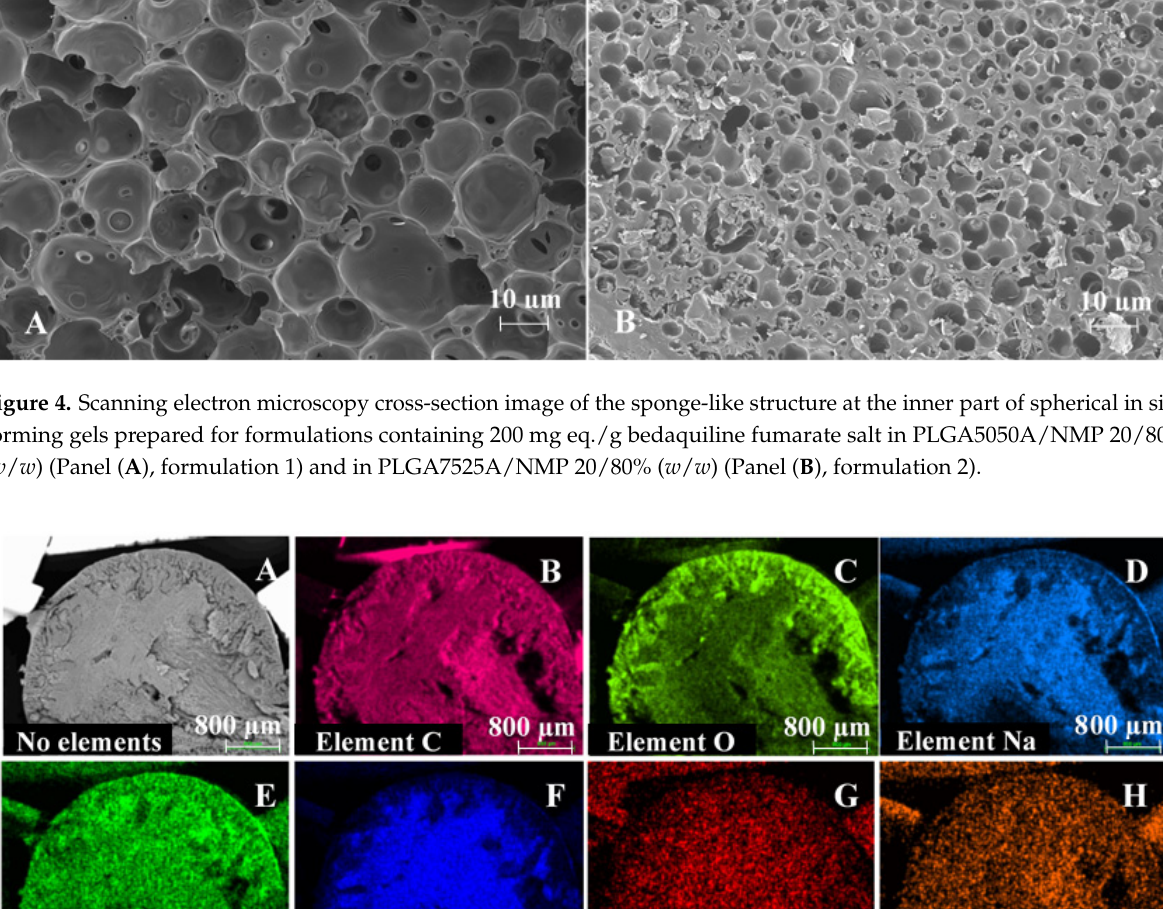
ing gels prepared for formulations containing 200 mg eq./g bedaquiline fumarate salt in PLGA5050A/NMP 20/80% ( w / w )